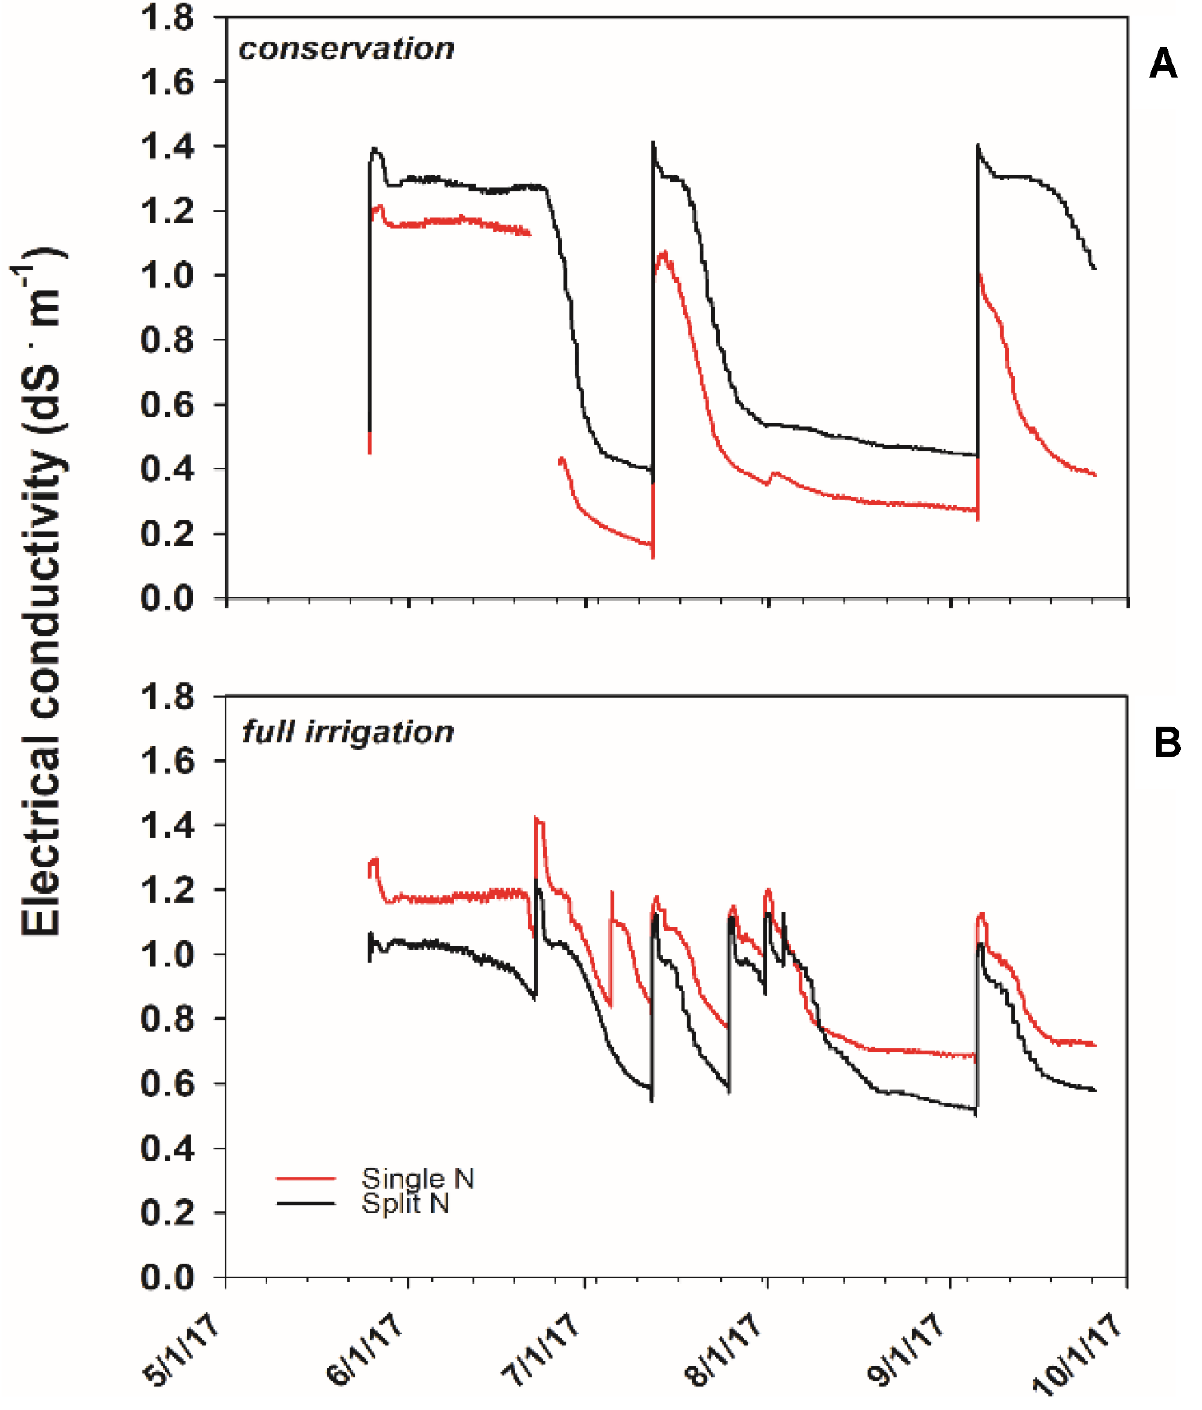
Figure 4. Soil electrical conductivity in sorghum fields under ( A ) 30% less irrigation and ( B ) full irrigation. Colored lines indicate fertilizer additions entirely at planting or split between 2 applica- tions.